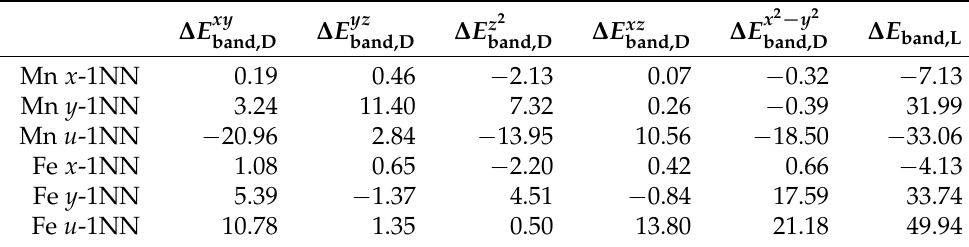
Table 3. Band energy differences between AFM and FM configurations in the 1NN Mn and Fe dimers. The band energy difference calculated for a single magnetic atom in the cluster is decomposed into atomic d orbitals according to Equation (9), and the majority and minority components are summed. The band energy differences of the whole self-consistently treated clusters between AFM and FM spin configurations divided by the number of magnetic atoms are also given based on Lloyd’s formula ( ∆ E band,L ). All reported values are in meV units.